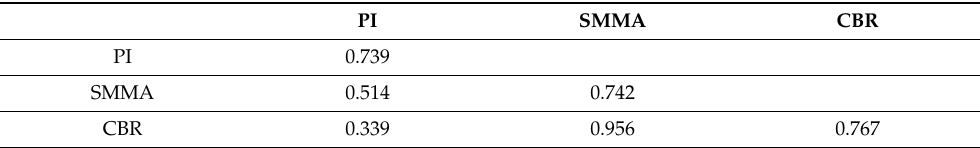
Table 5. Construct validity and inter-construct correlations.